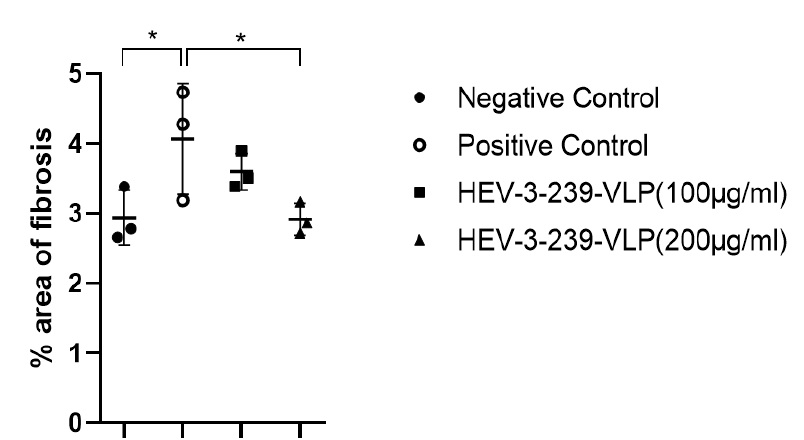
Figure 6. Percentage of the area of fibrosis in the Masson’s trichrome-stained liver tissue slides. In the positive control group, the blue-stained connective tissue was significantly proliferated by HEV infection compared to other groups. The proliferation of liver connective tissue caused by HEV infection was prevented by the HEV-3-239 VLP vaccination. Statistical analysis was conducted between the negative control pigs and positive control ones and between the positive control pigs and vaccinated ones. * p < 0.05.